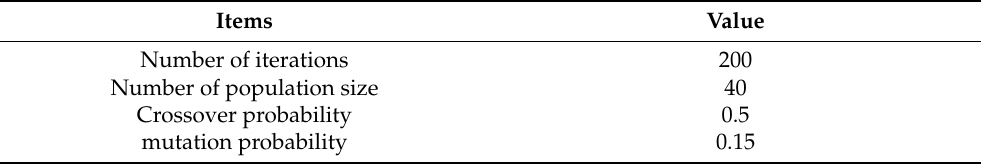
Table 3. Parameters setting of the used GA [26].